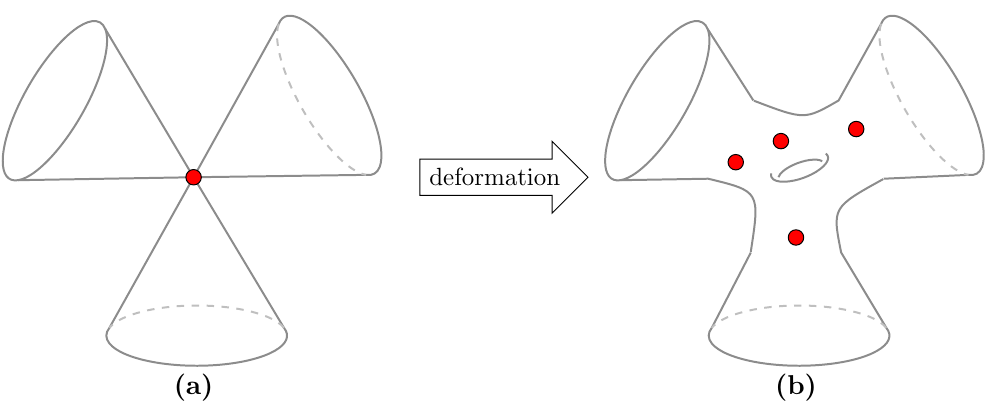
Figure 1 . (a) A scale-invariant CB which is a bouquet of 3 cones: the conformal vacuum is the common tip of the cones, while at all other points conformality is spontaneously broken. (b) A \near" deformation of the scale-invariant geometry, in which the conformal singularity splits into several conical or cusp-like metric singularities (the red dots) without a(cid:11)ecting the asymptotically far geometry, while the complex geometry desingularizes into that of a 3-punctured genus-1 Rie- mann